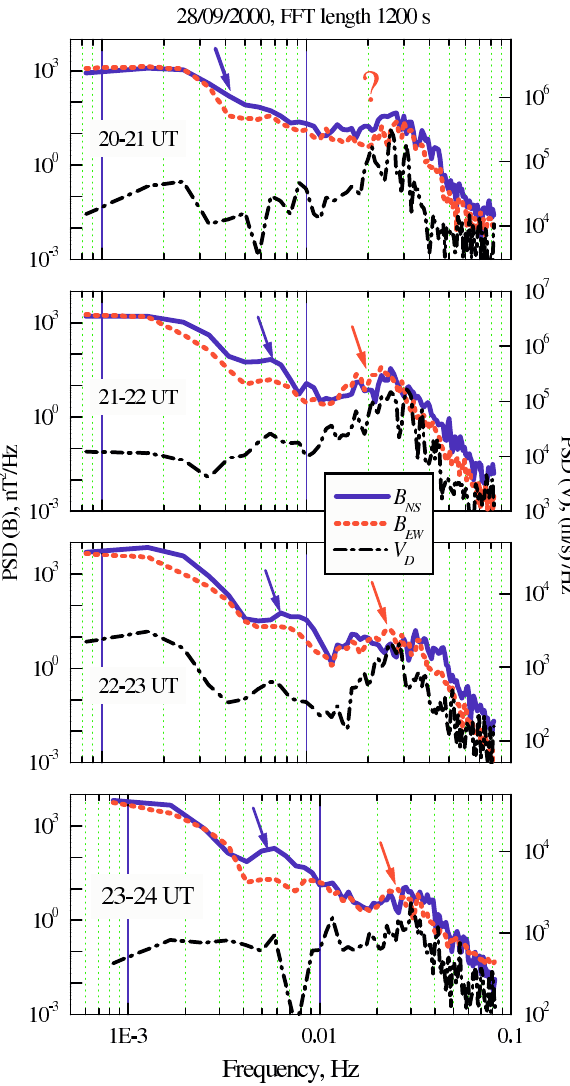
Fig. 7. The same as in Fig. 6 but with higher frequency resolution δf =0.83mHz (FFT-length 1200s), which resolves Pc4–5 compo- nents. Red arrows still identify a likely poloidal FLR harmonic, while blue arrows identify the fundamental toroidal resonance.